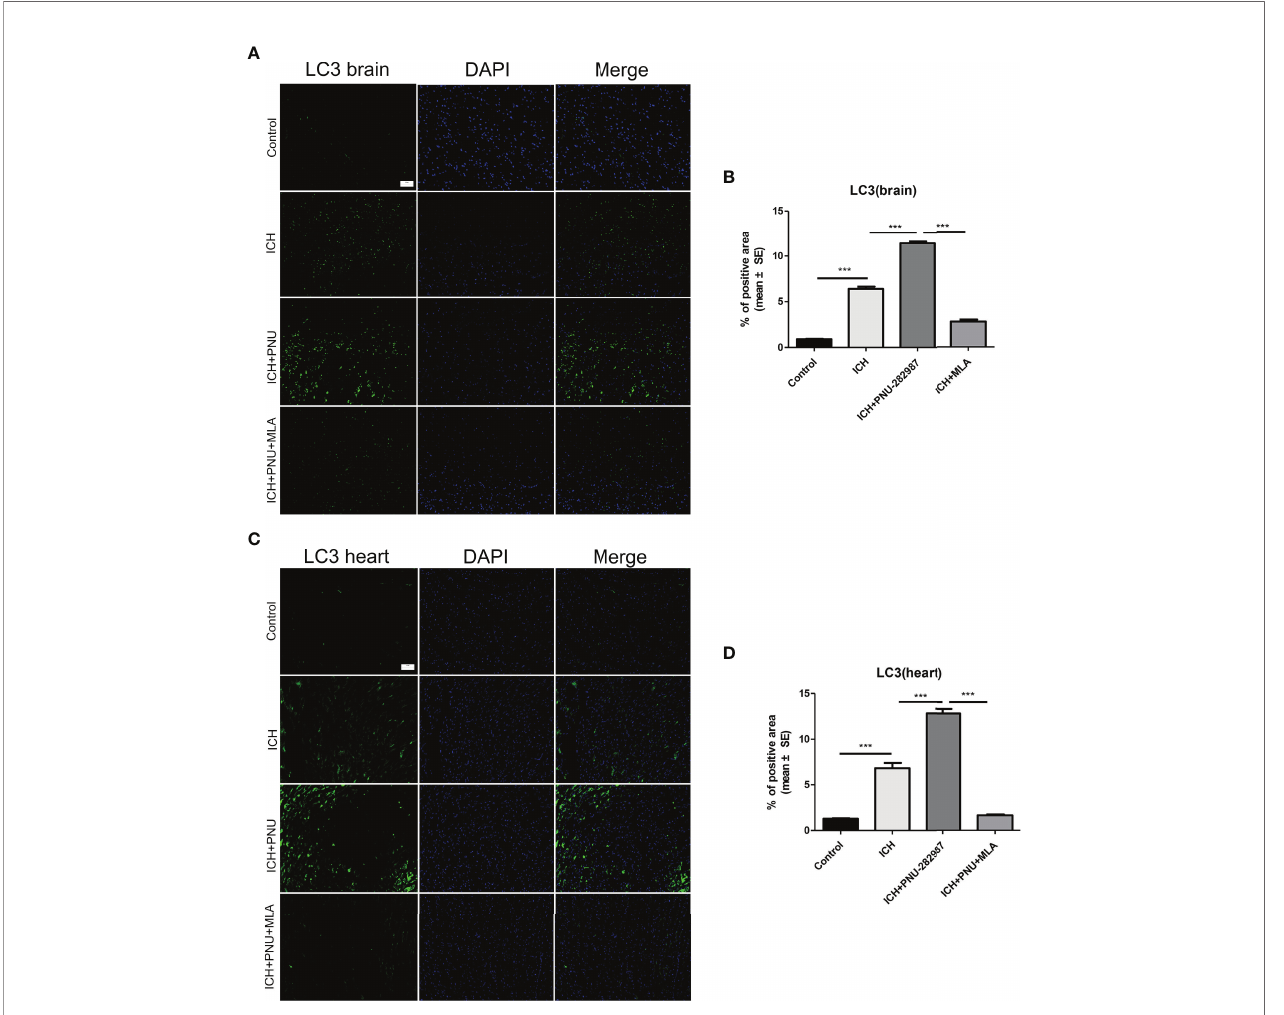
FIGURE 5 | Activating a 7nAChR induced autophagy in the brain and heart of ICH mice. (A) Immuno fl uorescence staining of LC3 from brain tissue of control, ICH, ICH+PNU-282987 and ICH+PNU-282987+MLA (scale bar, 100 m m). (B) The quantitation of LC3 in brain. (C) Immuno fl uorescence staining of LC3 from heart tissue of control, ICH, ICH+PNU-282987 and ICH+PNU-282987+MLA (scale bar, 100 m m). (D) The quantitation of LC3 in heart. n= 6 per group. Data are presented as mean ± SE; ***P <